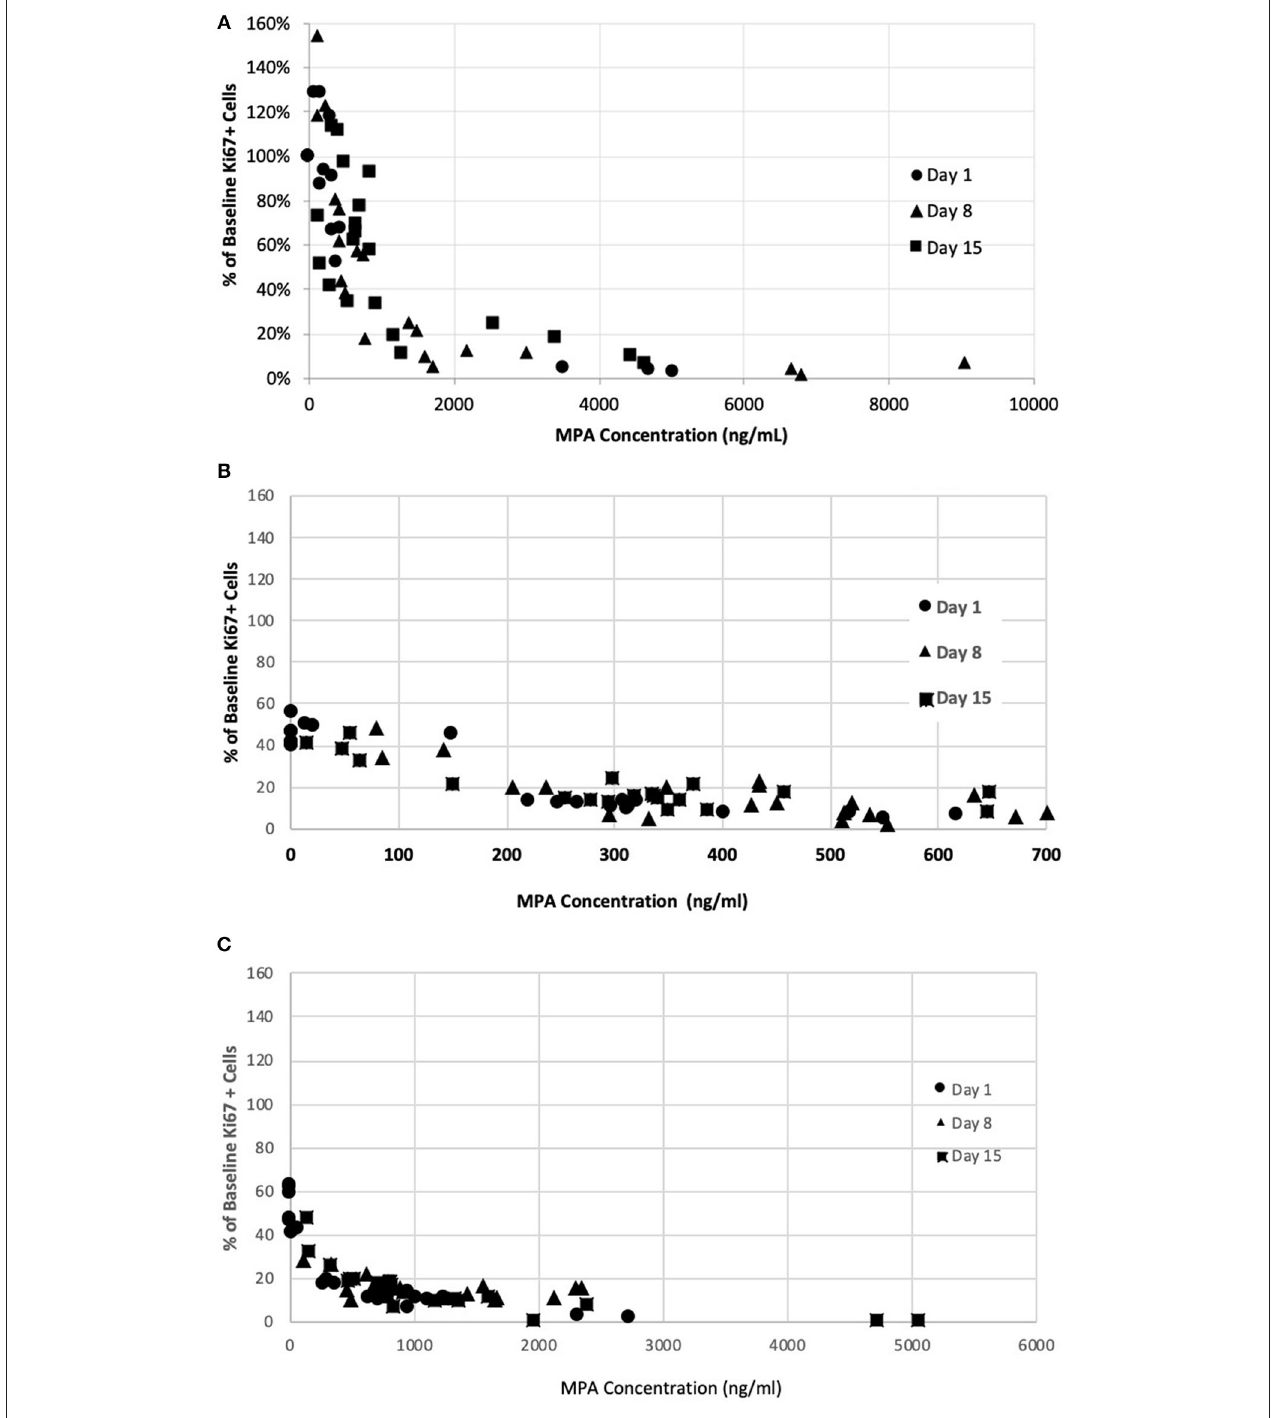
FIGURE 4 | Correlation between MPA plasma concentration in healthy dogs and inhibition of mitogen-stimulated T-lymphocyte proliferation after administration of single- and repeat-doses of MMF (A) , OKV-1001b180 (B) , OKV-1001b270 (C) .